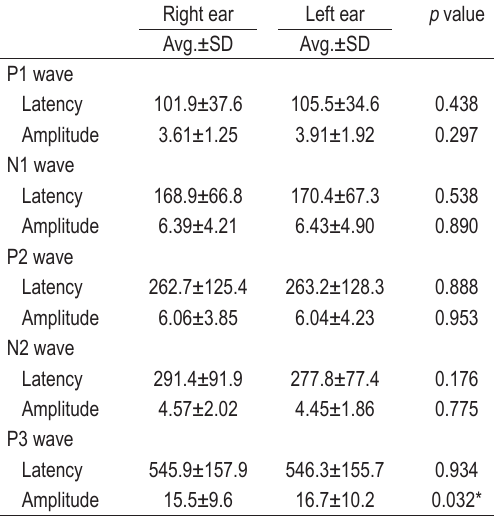
TABLE 2. Mean value, standard deviation, and p value of the left and right ears regarding P1, N1, P2, N2, and P3